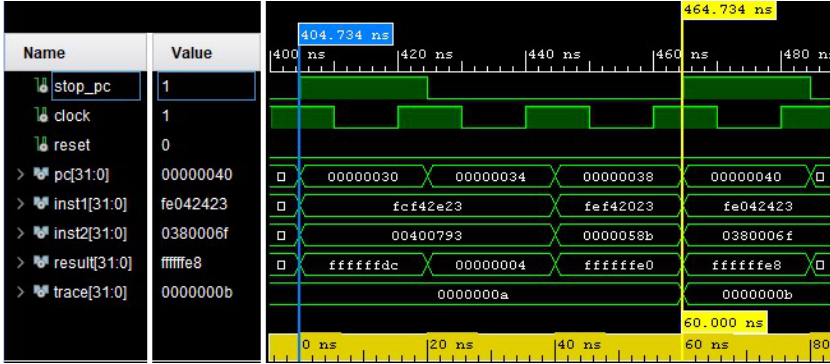
Figure 8. Waveform of the example’s result execution on a modified